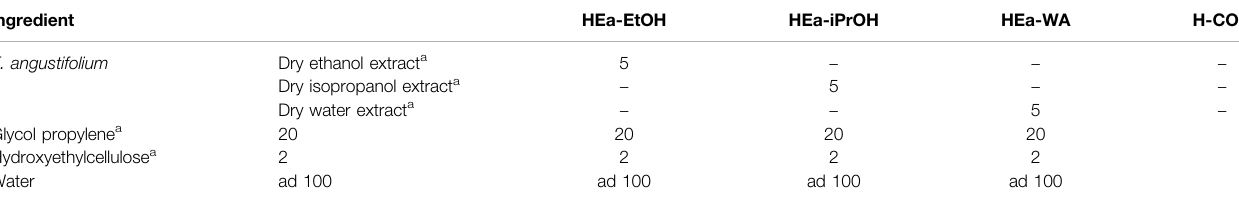
TABLE 1 | The E. angustifolium hydrogels